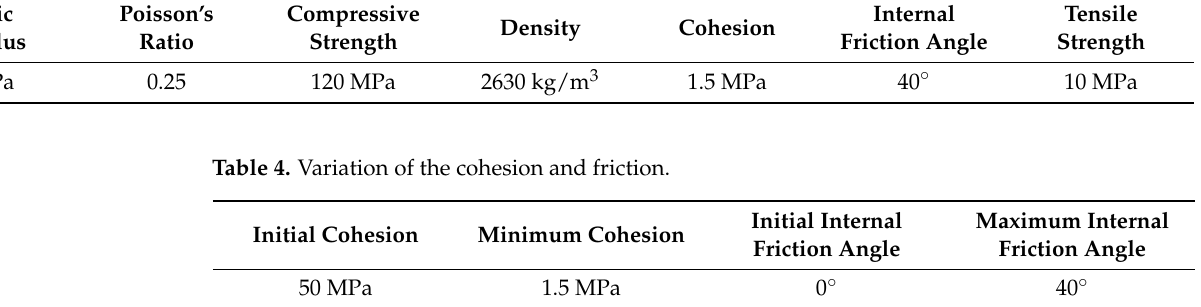
Table 5. In situ stress at elevation 420.